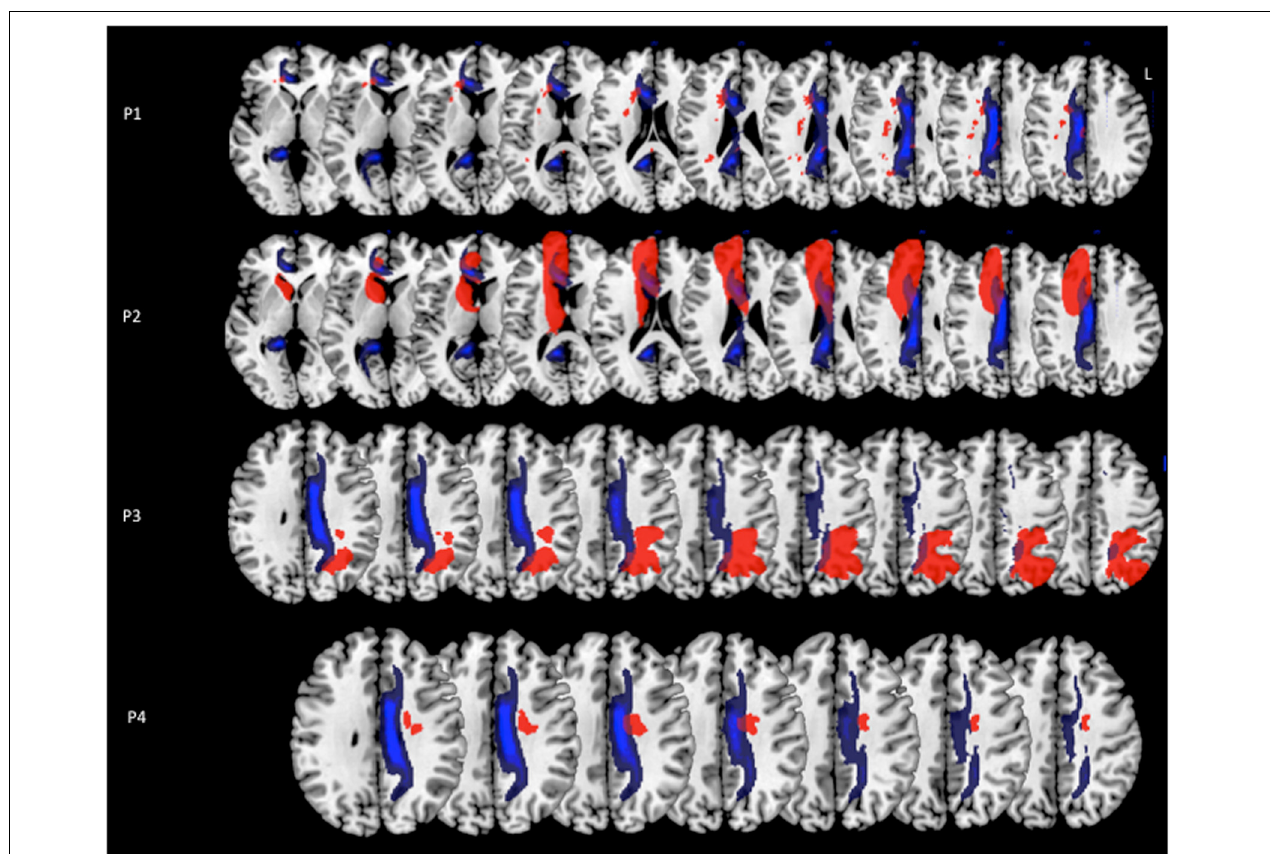
FIGURE 2 | Lesion reconstructions (in red) for each MN patient on the axial sections of the Montreal Neurological Institute (MNI) standard brain in radiological convention (L, left). A reconstruction of the cingulum (in blue)